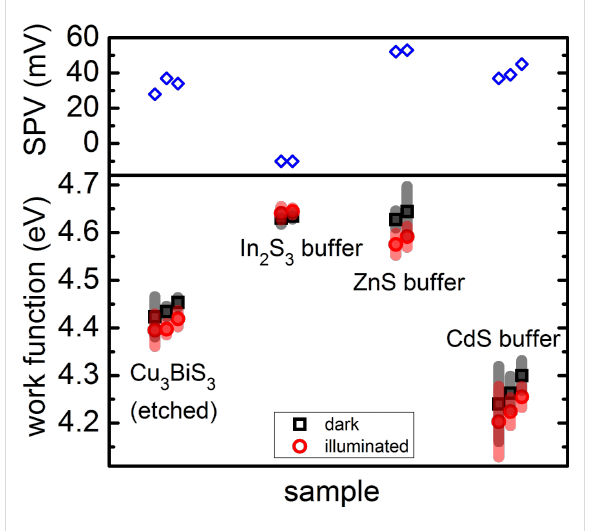
Figure 3: Overview of the measured work-function values and their distribution for all samples investigated. Black squares indicate values for measurements in the dark and red circles for measurements under illumination. The spread of the work function is indicated by the gray and light red bars around the data